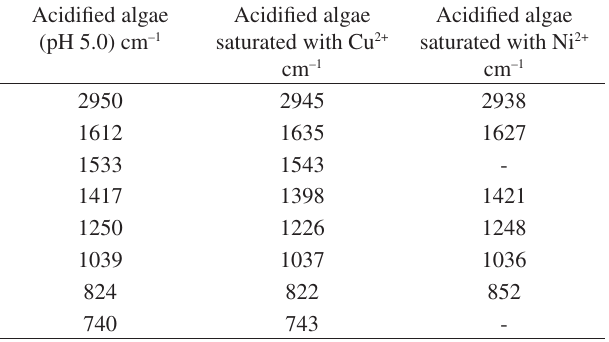
Table 5. Changes promoted by Cu 2+ and Ni 2+ loading in acidified algae. Acidified